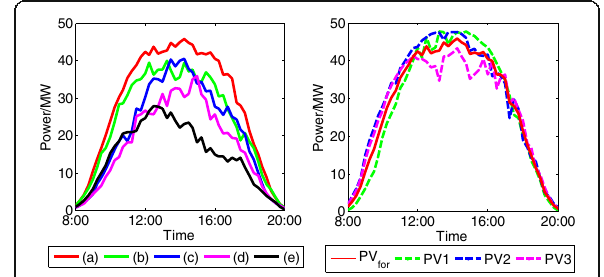
Fig. 4 Typical scenarios and the output curves of representative scenario in